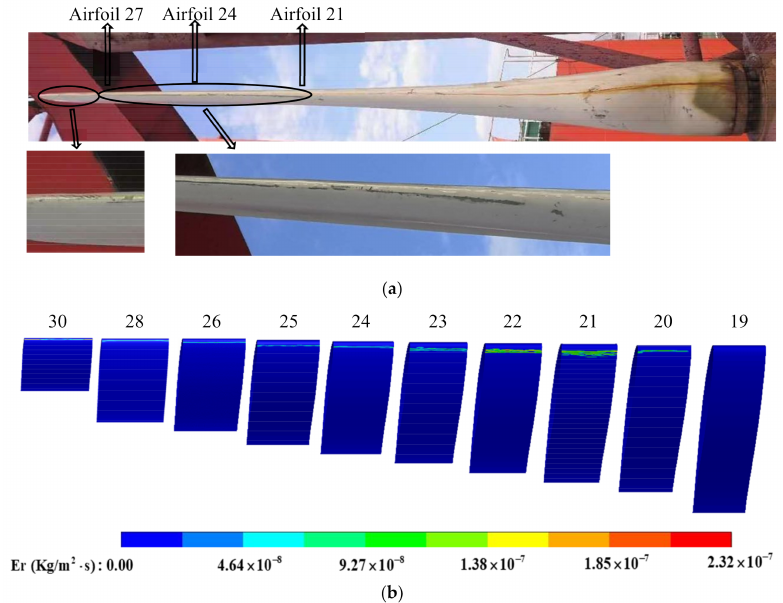
Figure 8. Erosion diagram of the 120 kW tidal current turbine: ( a ) the actual erosion diagram under real sea conditions; ( b ) the simulated erosion cloud diagram at 1.8 m/s (blade contains 30 airfoil elements, the airfoil element at the tip is named “airfoil 30”, and the others are named in sequence. Additionally, Er represents the average erosion